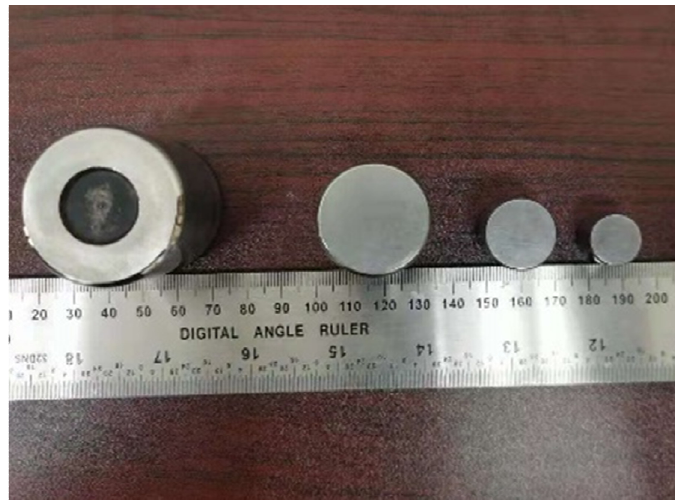
Figure 11. The photo of cylindrical targets.